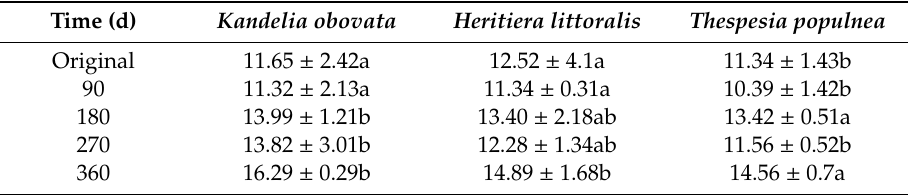
Table 3. Organic carbon concentration (g/kg) in the surface soil layer (0–5 cm) underneath the added litter for the three selected mangrove plant species.